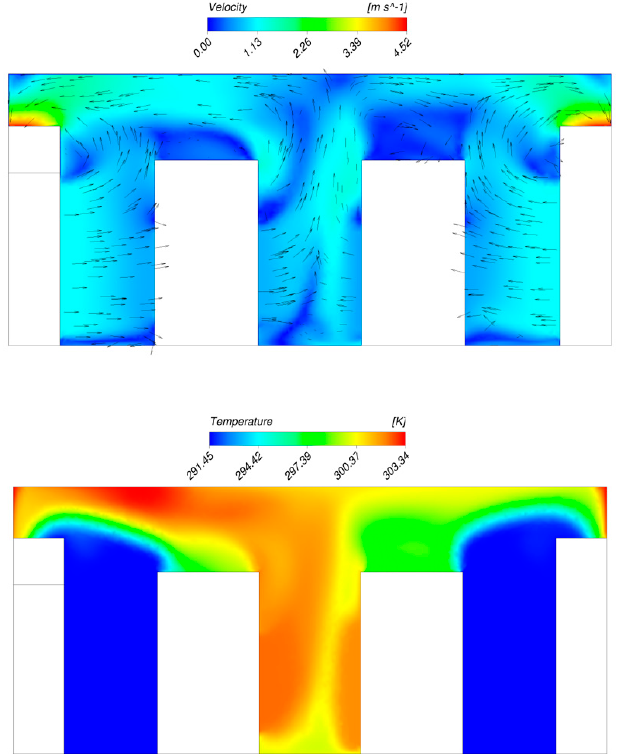
Figure 5. Velocity and temperature on a plane through the center of computer room air handler (CRAH) 2 and 4 (see Figure 2) in the hard floor configuration with an open aisle.